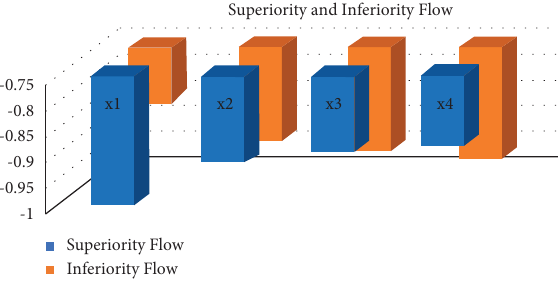
Figure 1: Superiority and inferiority fow. Table 5: Comparison between proposed and existing work.